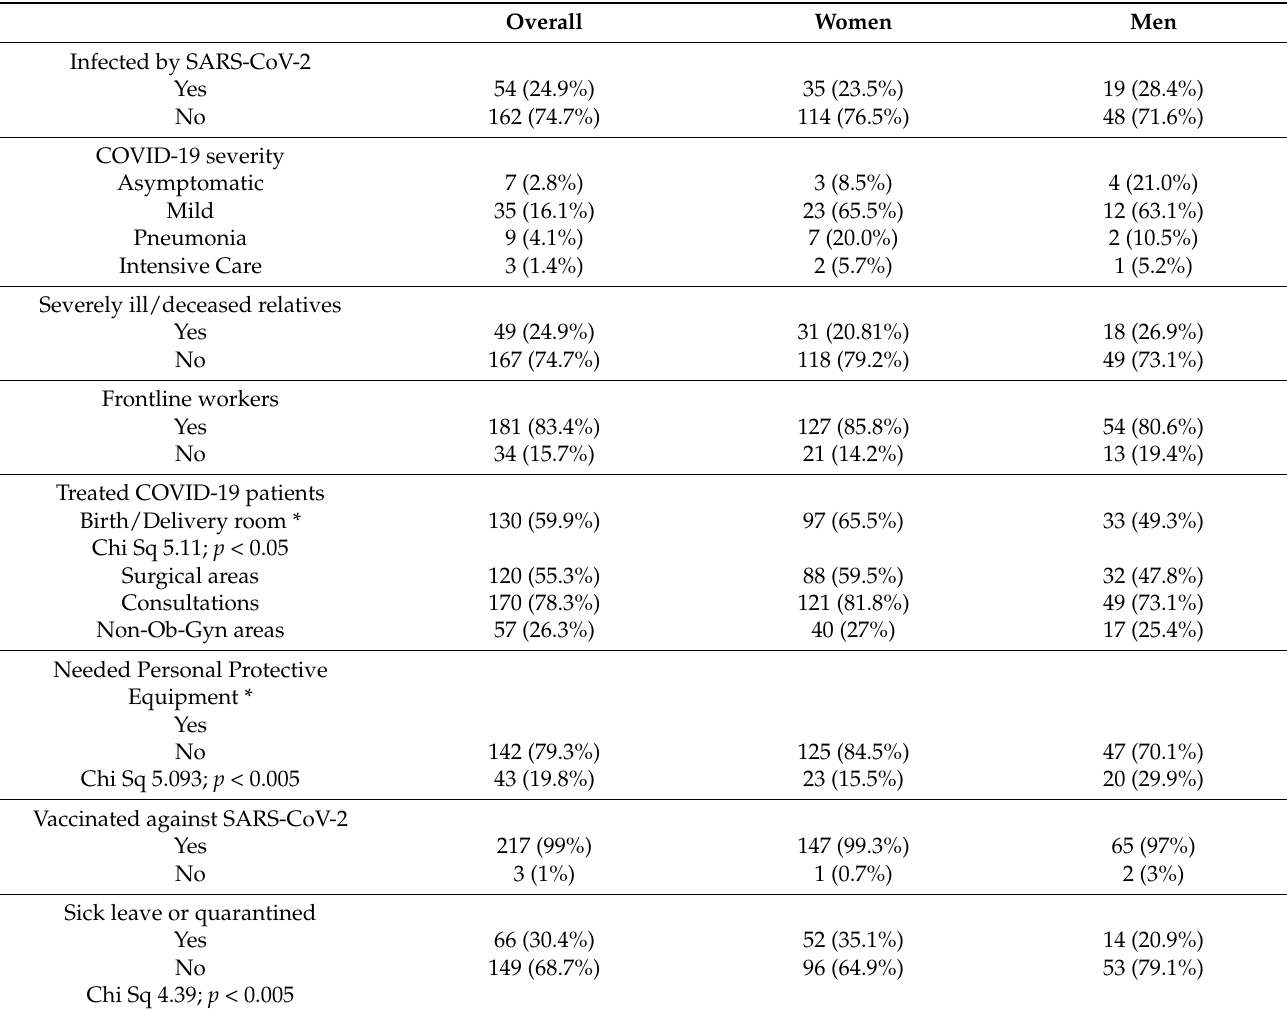
Table 3. Activity of the participants during the pandemic.